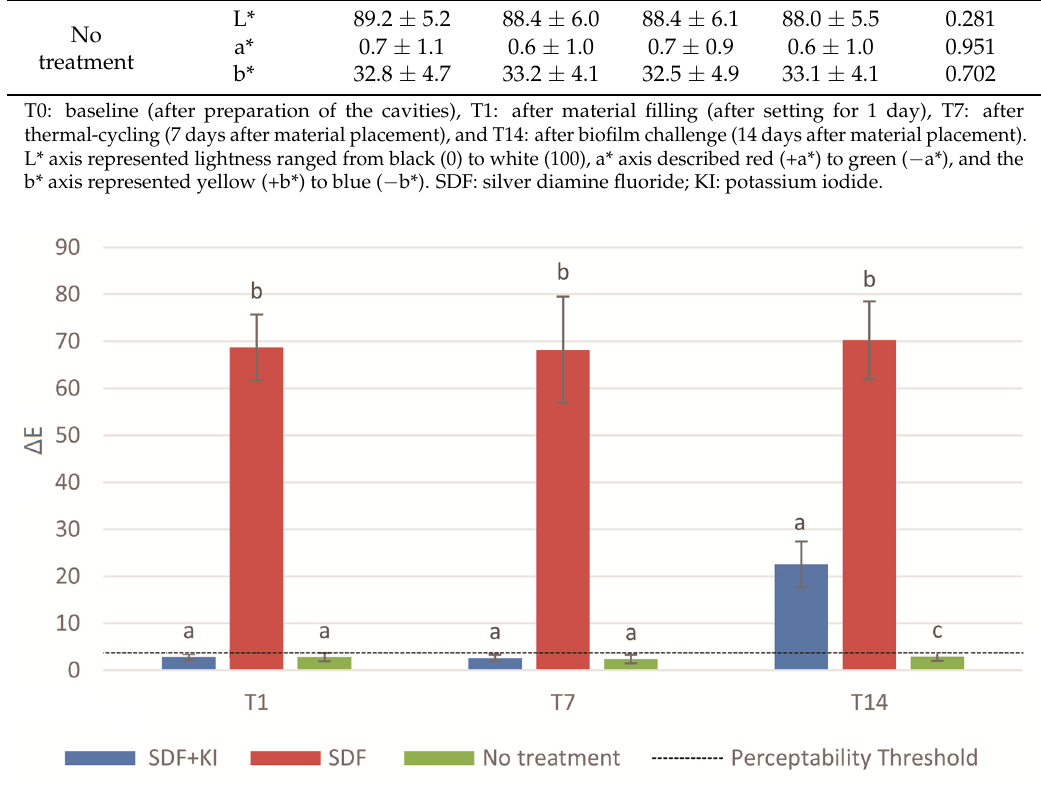
Figure 1. Total colour change ( ∆ E) of the three groups. T1: after material filling (after setting for 1 day), T7: after thermal-cycling (7 days after material placement), and T14: after biofilm challenge (14 days after material placement). Columns displaying different letters indicate a significant difference ( p < 0.05) between groups within each time point.